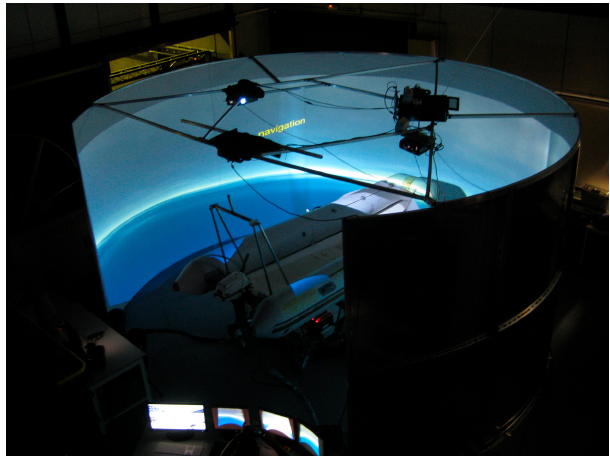
Figure 9. Full-boat vehicle simulation with cylindrical screens (vehicle controls are not shown).